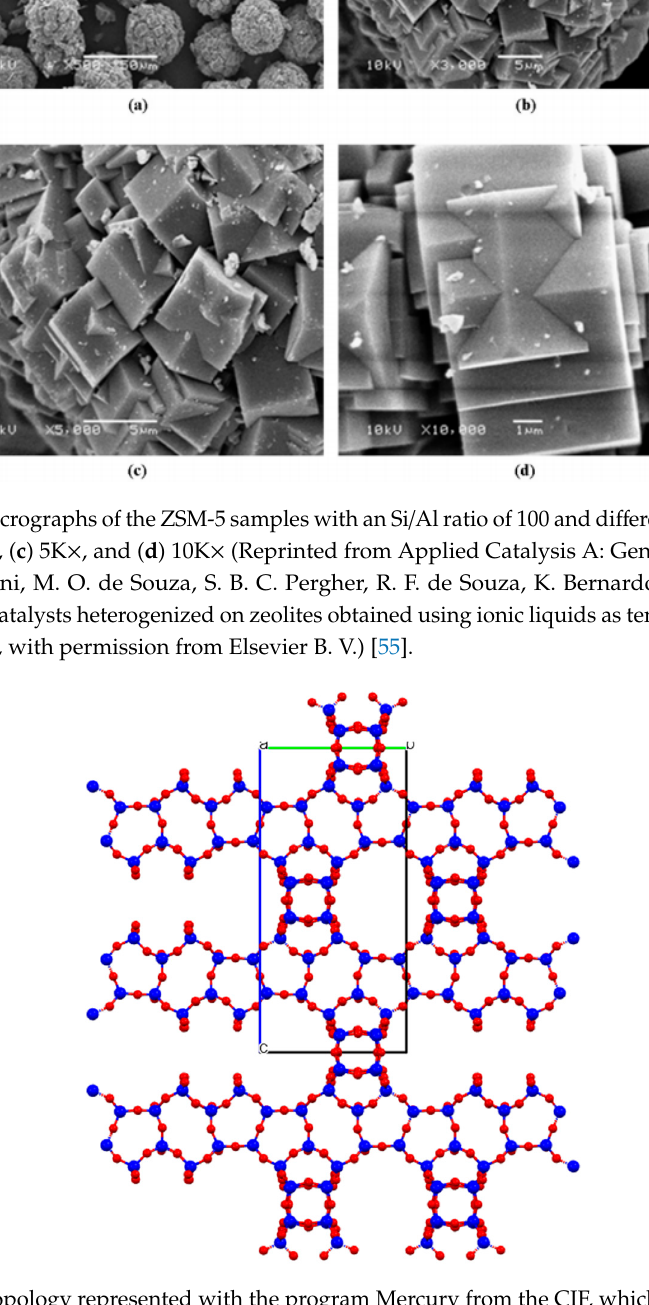
Figure 3. *BEA topology represented with the program Mercury from the CIF, which was provided by the International Zeolite Association (IZA) [8,58]. The oxygen atoms are red, and the silicon/aluminum atoms are in blue.